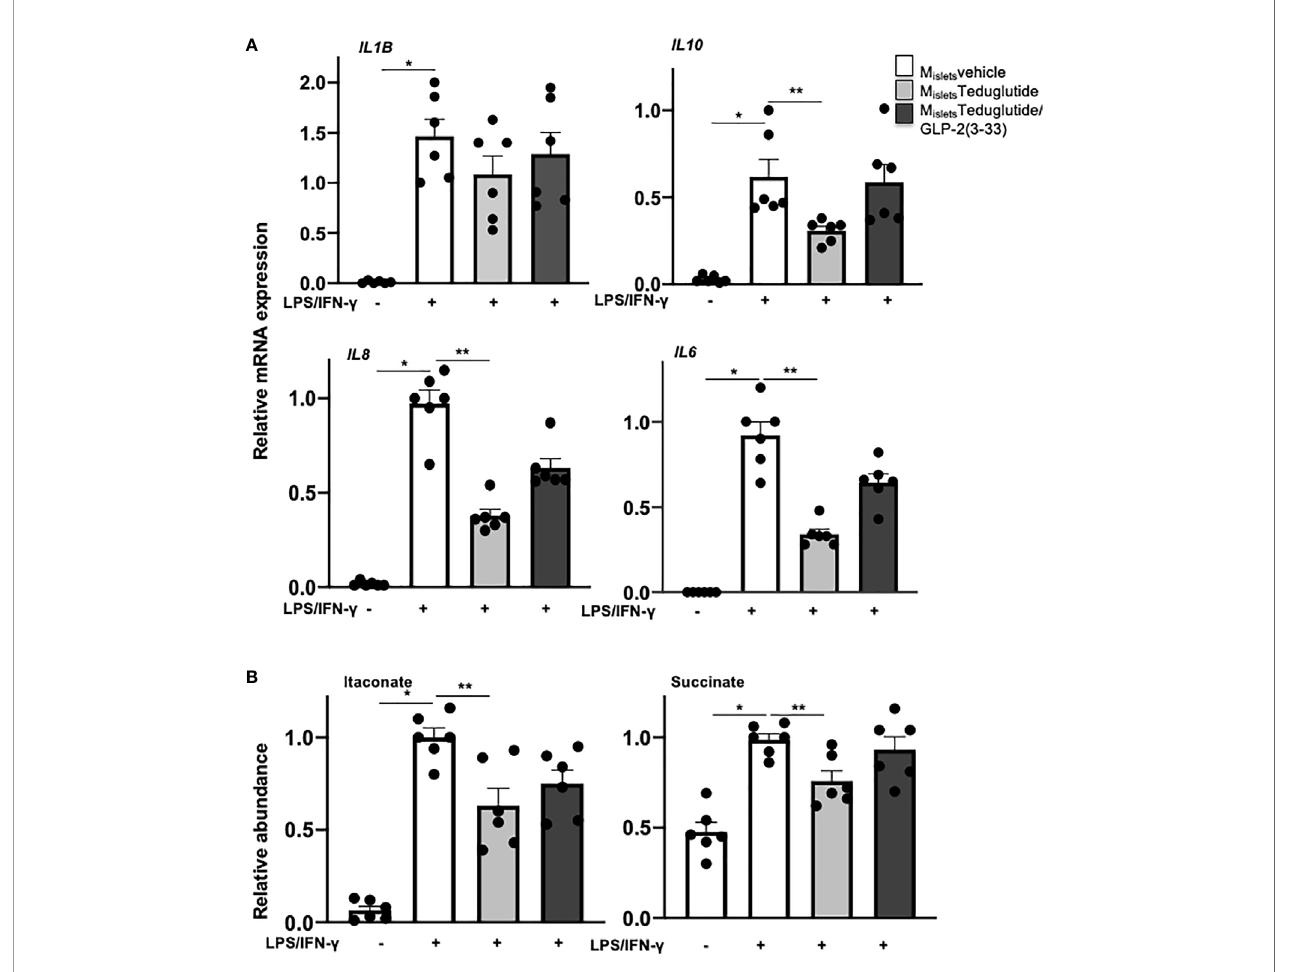
FIGURE 5 | Conditioned medium from teduglutide-treated islets attenuated M1 polarization of human macrophages. Primary human monocyte-derived macrophages (by M-CSF) were cultured in medium pre-conditioned by cultured untreated human islets (M islets vehicle) or islets treated with teduglutide alone (M islets Teduglutide) or combined with GLP-2(3-33) (M islets Teduglutide/GLP-2(3-33)) for 2h, then LPS/IFN- g was added to the culture and maintained for 8h to induce M1-like polarization, followed by (A) total RNA isolation and cytokine expression analysis by realtime RT-PCR and (B) intracellular metabolite extraction and measurement by GC-MS. Data are presented as means ± SEM from n=6 biological replicates pooled from two independent experiments of two different macrophage preparations. *p < 0.05 LPS/IFN- g vs . control, **p < 0.05 M islets Teduglutide vs . M islets vehicle LPS/IFN- g by 1-way ANOVA with Dunnet ’ s